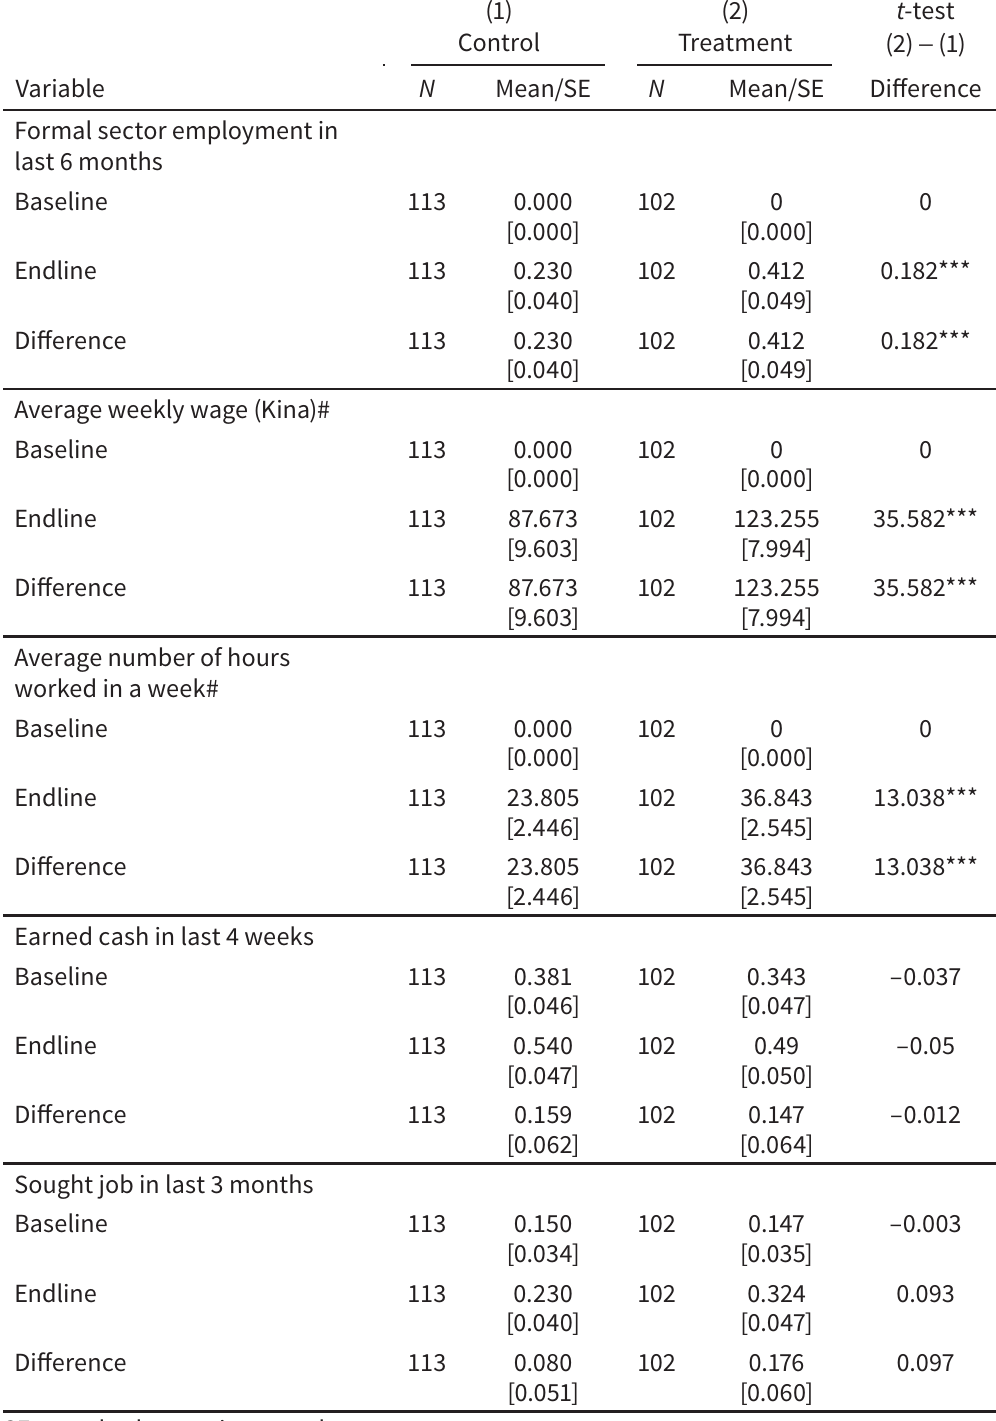
Table 5 Effect of the program on employment and job-seeking behavior (1) (2) t -test Control Treatment (2) -